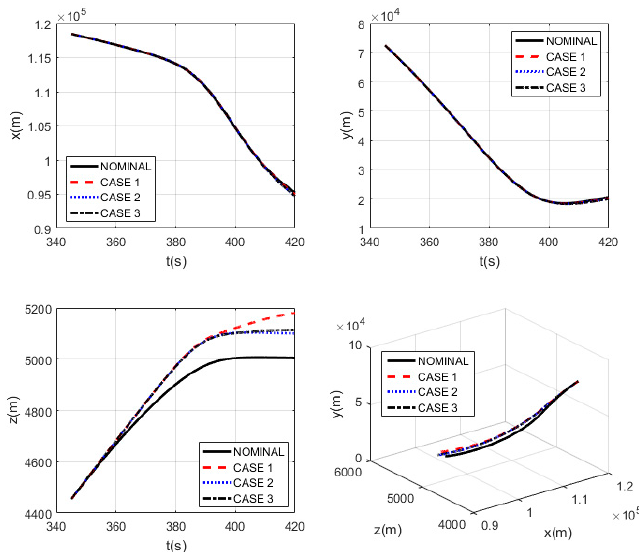
Figure 4. The flight trajectories of the reusable launch vehicle (RLV).